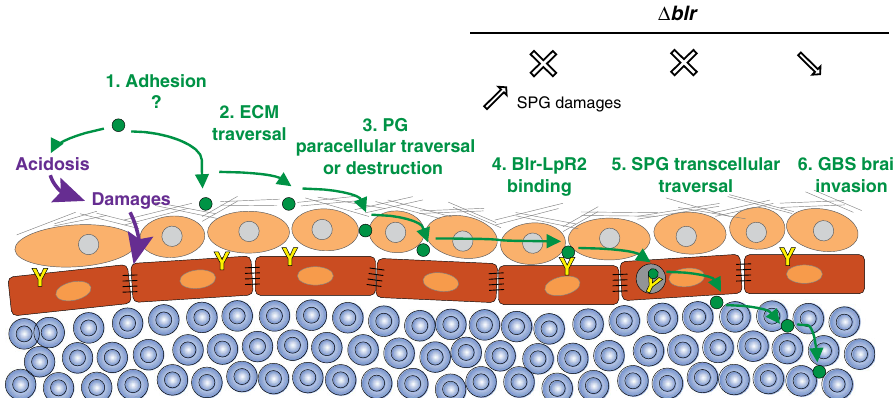
Fig. 7 Proposed model for the mechanisms used by GBS during BBB crossing. GBS (green circle) fi rst has to adhere to the ECM layer, before making its way through. It then crosses the PG layer through a paracellular mechanism and/or cellular damages, likely supported or enhanced by acidosis. The bacteria adhere to the SPG surface via Blr-LpR2 (yellow Y) interaction, allowing its internalisation through endocytosis and leading to its transcellular traversal. In the absence of Blr, GBS uses an alternative, albeit less ef fi cient, mechanism for brain invasion, via SPG damages through an unknown